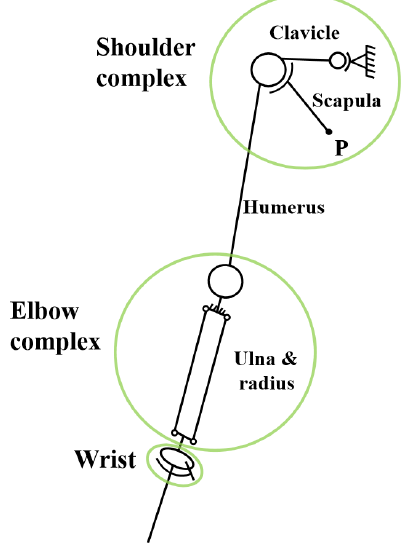
Figure 3. The equivalent kinematic model of the human